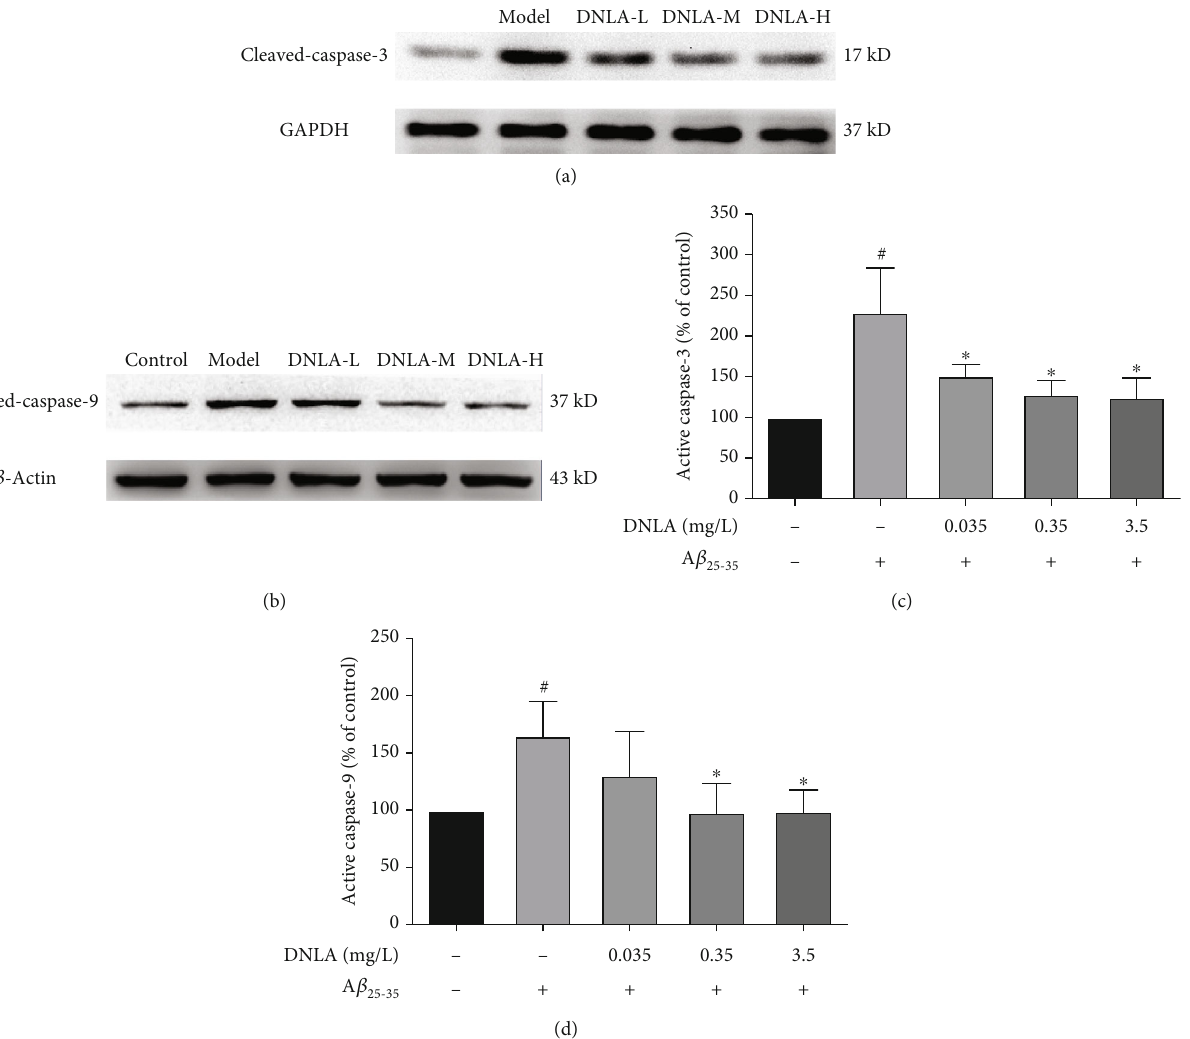
Figure 8: E ff ect of DNLA on the expression of cleaved-caspase-9 and cleaved-caspase-3induced by A β in PC12 cells. (a) Respective 25-35 . (b) Respective photomicrographs of cleaved-caspase-3 in photomicrographs of cleaved-caspase-9 in PC12 cell damage induced by A β 25-35 PC12 cell damage induced by A β . (c) The cleaved-caspase-9 activity in PC12 cells ( n = 3 , (cid:1) x ± s ). (d) The cleaved-caspase-3 activity in 25-35 PC12 cells ( n = 3 , (cid:1) x ± s ). Note: # P < 0 : 05 vs. control; ∗ P < 0 : 05 vs.